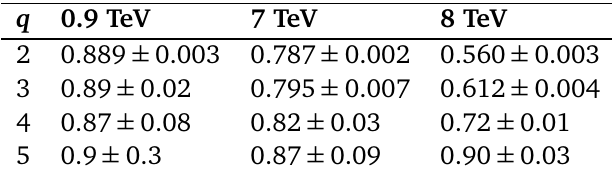
Table 1: Summary of intermittency